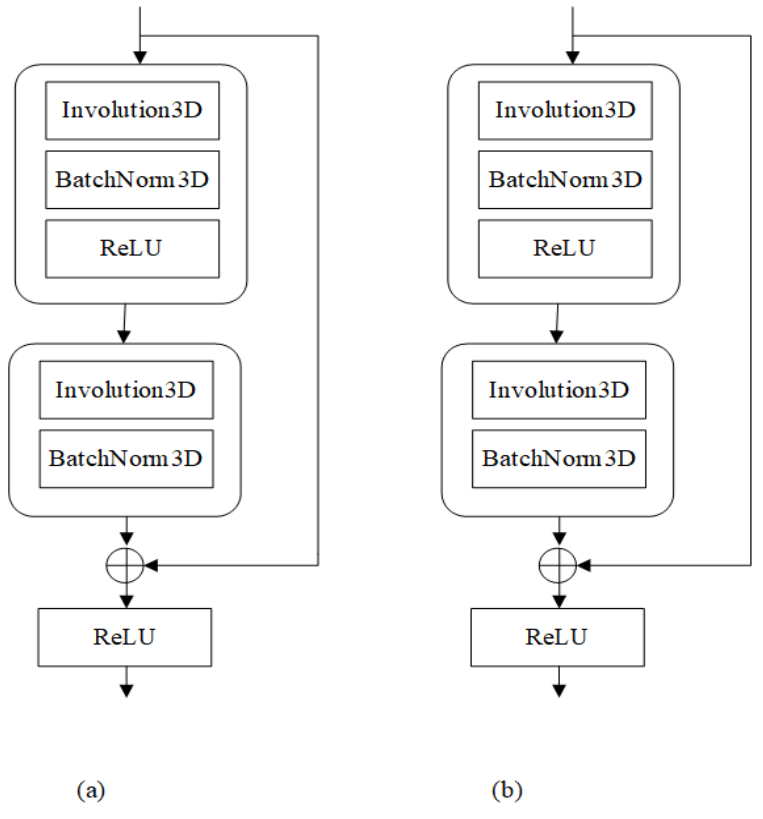
Figure 9. 3D ResNet-18 network structure. ( a ) ResBlock module. ( b ) ResDown